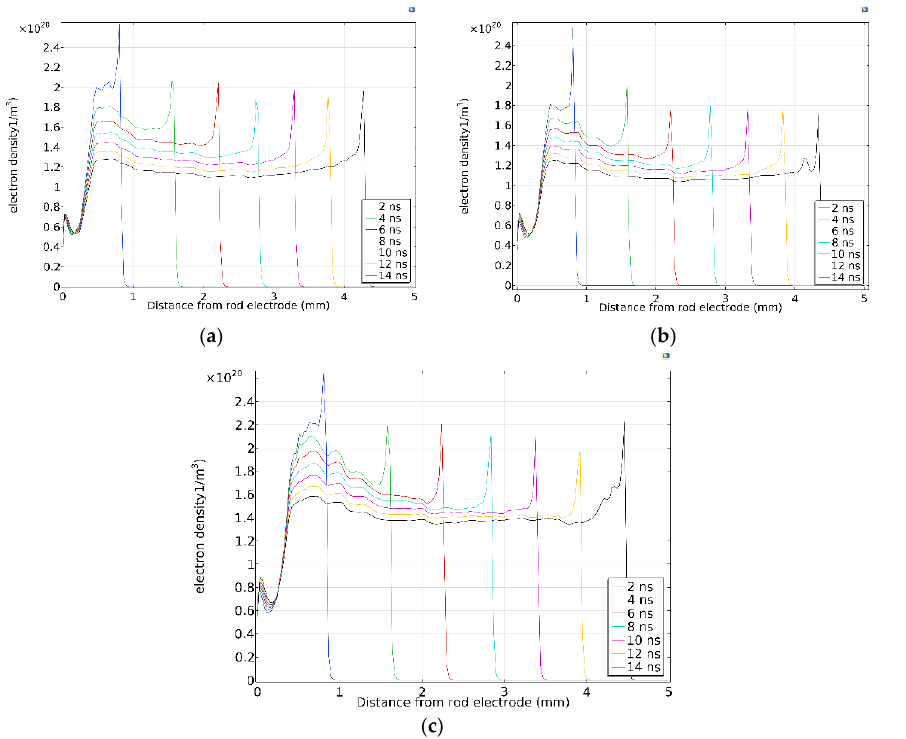
Figure 2. One-dimensional distribution of electron concentration along the axis: ( a ) Dry clean air, ( b ) 40% relative humidity, ( c ) 80% relative humidity.